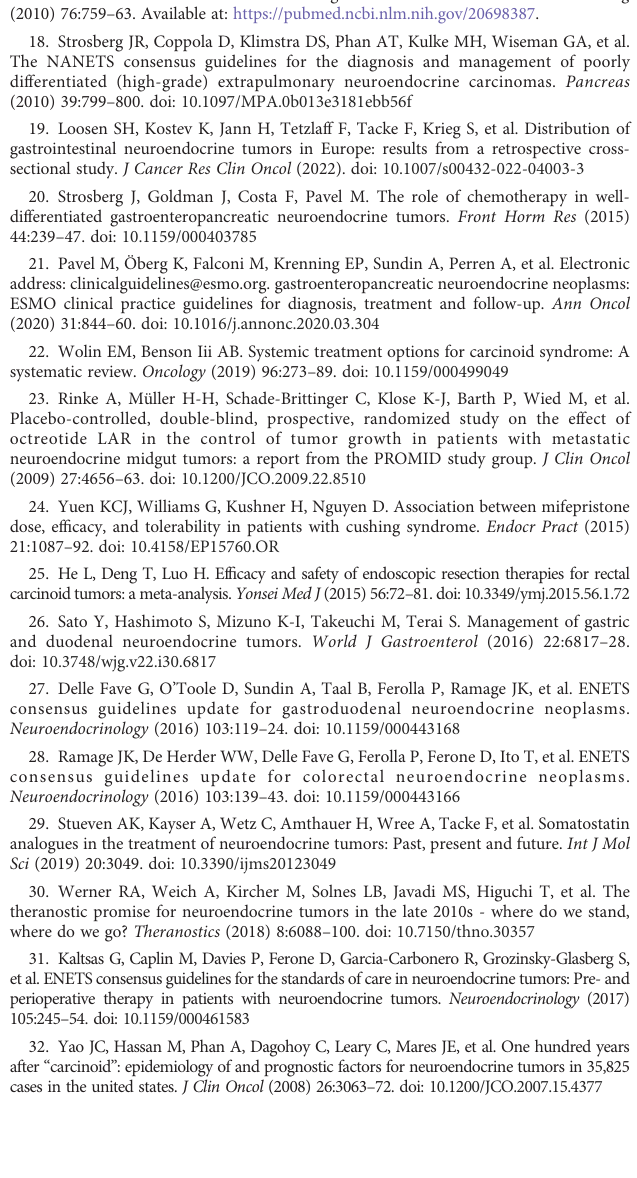
SUPPLEMENTARY FIGURE 1 Trends in relative survival rate (A – C) and Kaplan – Meier survival curves (D – G) for patientswithGI-NETsat9SEERsitesaccordingtoSESgroup(lowpoverty,medium poverty,andhighpoverty)in1977 – 1986,1987 – 1996,1997 – 2006,and2007-2016. SUPPLEMENTARY FIGURE 2 Trendsinrelativesurvivalrate (A – C) andKaplan – Meier survivalcurves (D – G) for patients with GI-NETs at 9 SEER sites according to grade group (G1, G1, and G3&4) in 1977 – 1986, 1987 – 1996, 1997 – 2006, and 2007-2016. SUPPLEMENTARY FIGURE 3 Trends in relative survival rate (A – C) for patients with GI-NETs at 9 SEER sites according to site group (stomach, small intestine, appendix, colon, rectum) in 1977 – 1986, 1987 – 1996, 1997 – 2006, and 2007-2016. SUPPLEMENTARY FIGURE 4 Kaplan – Meier survival curves (A – E) for patients with GI-NETs at 9 SEER sites according to site group (stomach, small intestine, appendix, colon, rectum) in 1977-2016, 1977 – 1986, 1987 – 1996, 1997 – 2006, and